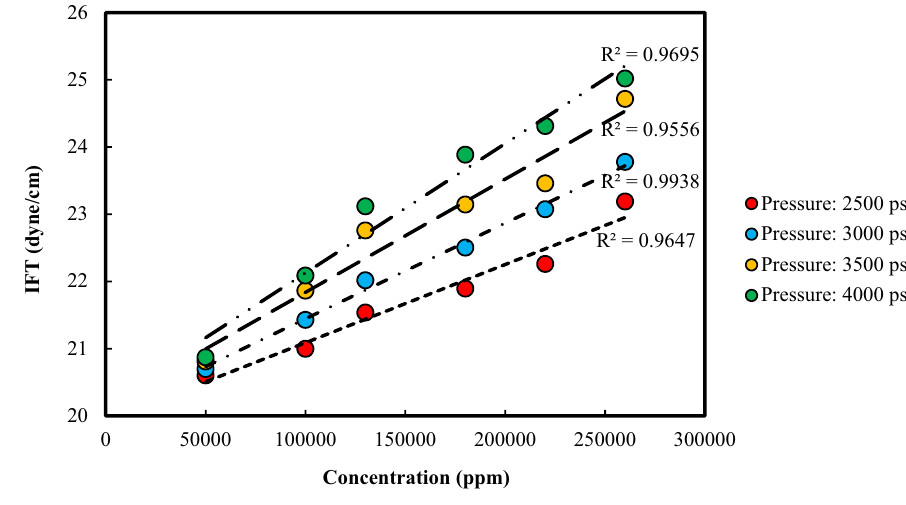
Fig. 3 IFT between oil sample A and brines at different concentrations and pressures at 25